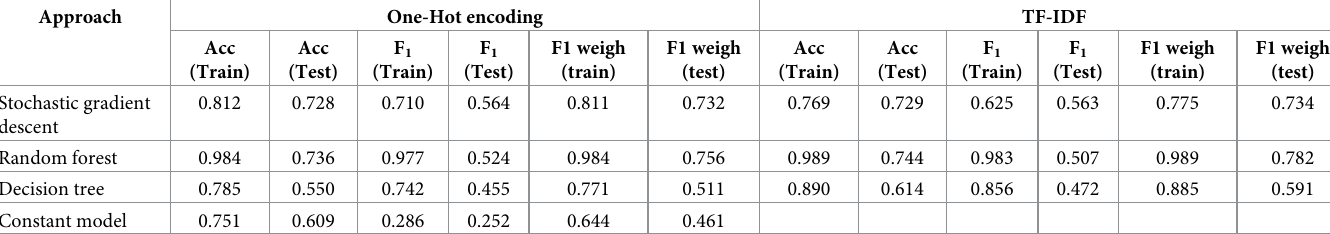
Table 3. Results of textual processing using a neural network and machine learning techniques. Approach